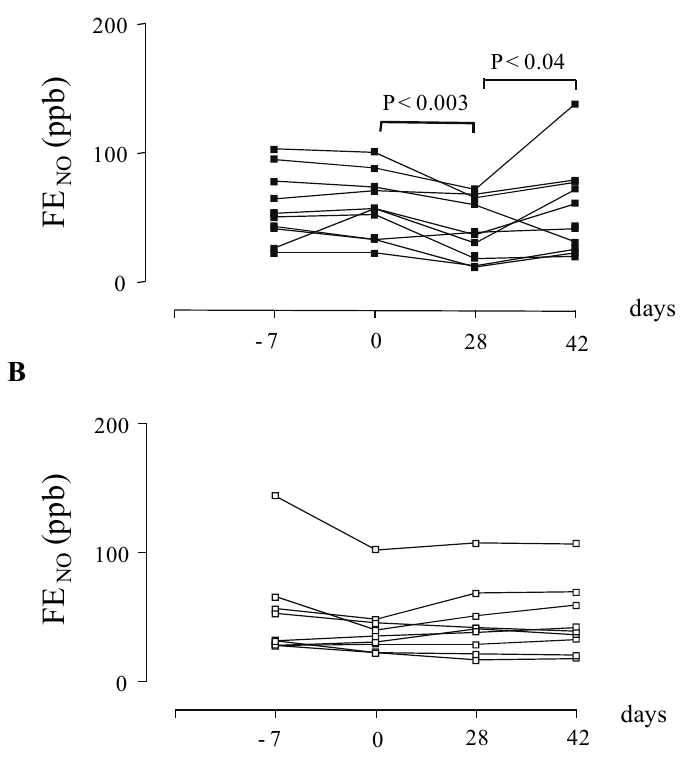
baseline (day -7), before treatment with montelukast (filled squares) (day 0), after treatment with oral montelukast (5 mg qd for four weeks) (day 28), and two weeks after NO in children with asthma (n = 12) at baseline montelukast withdrawal (day 42). (B) F E (day -7), before treatment with placebo (open squares) (day 0), after treatment with matching placebo (5 mg qd for four weeks) (day 28), and two weeks after placebo withdrawal (day 42). Values are expressed as mean ±